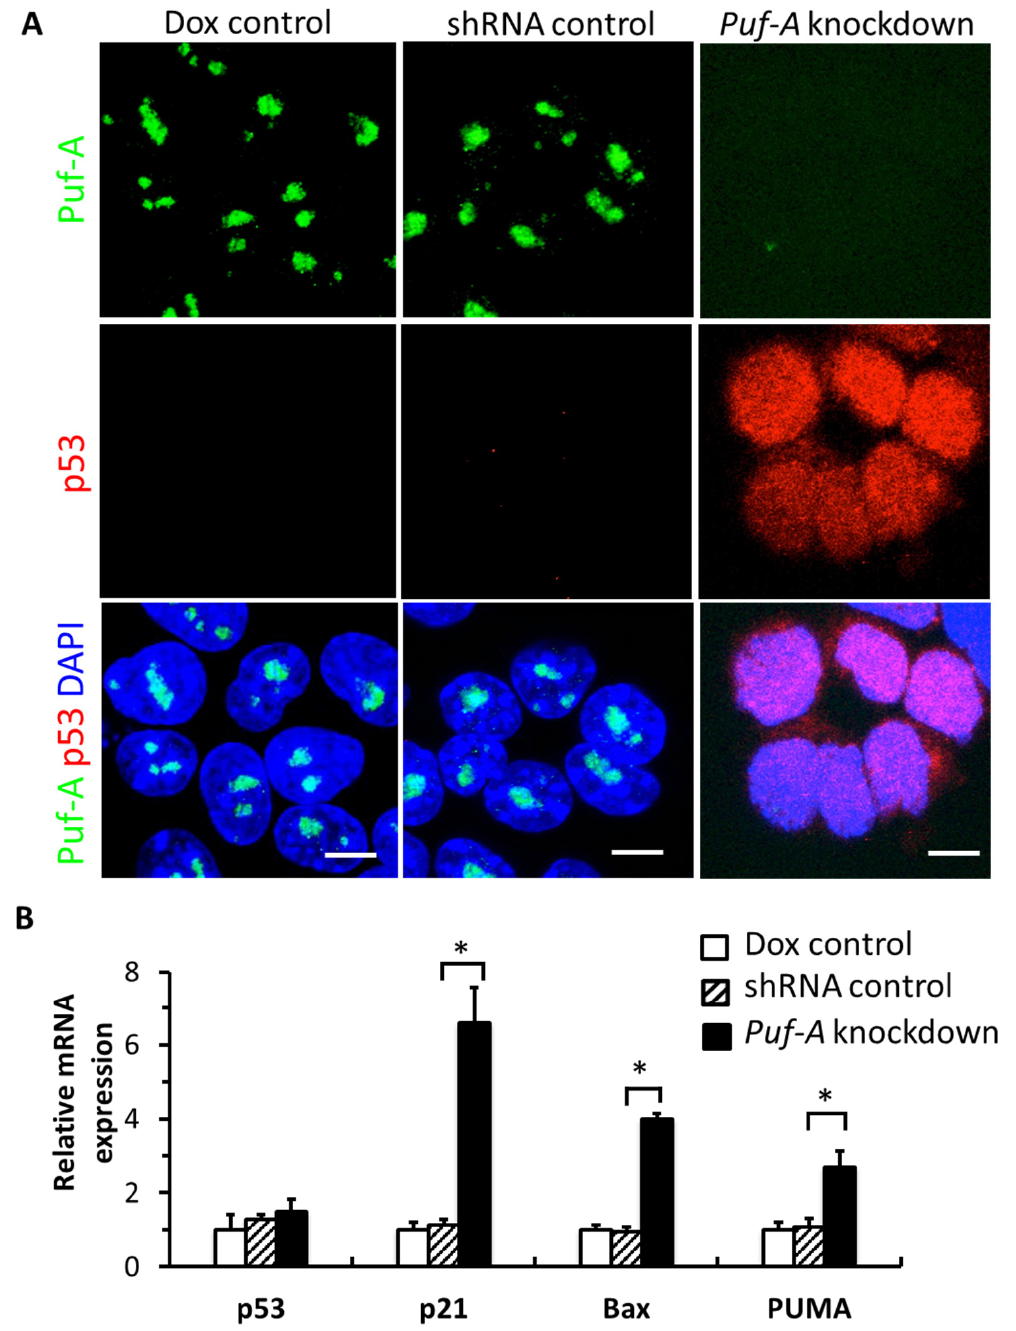
Figure 5. Puf-A knockdown activates p53 signaling in PGCs. ( A ) PGCs were immunostained with anti-p53 antibody (red), co-stained with anti-Puf-A antibody (green) and DAPI (blue). Extremely